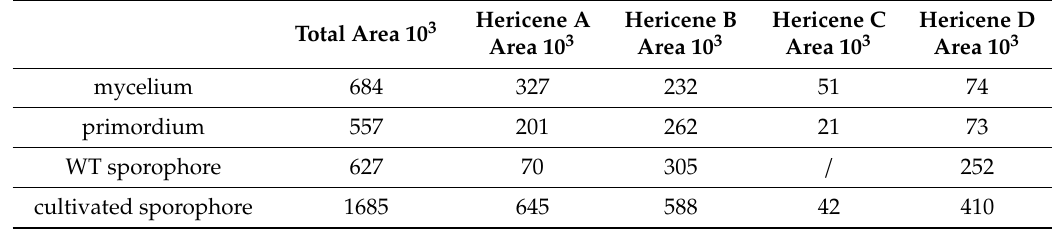
Table 6. Content of hericenes in mycelium, primordium, and wild type (WT) and cultivated sporophores.